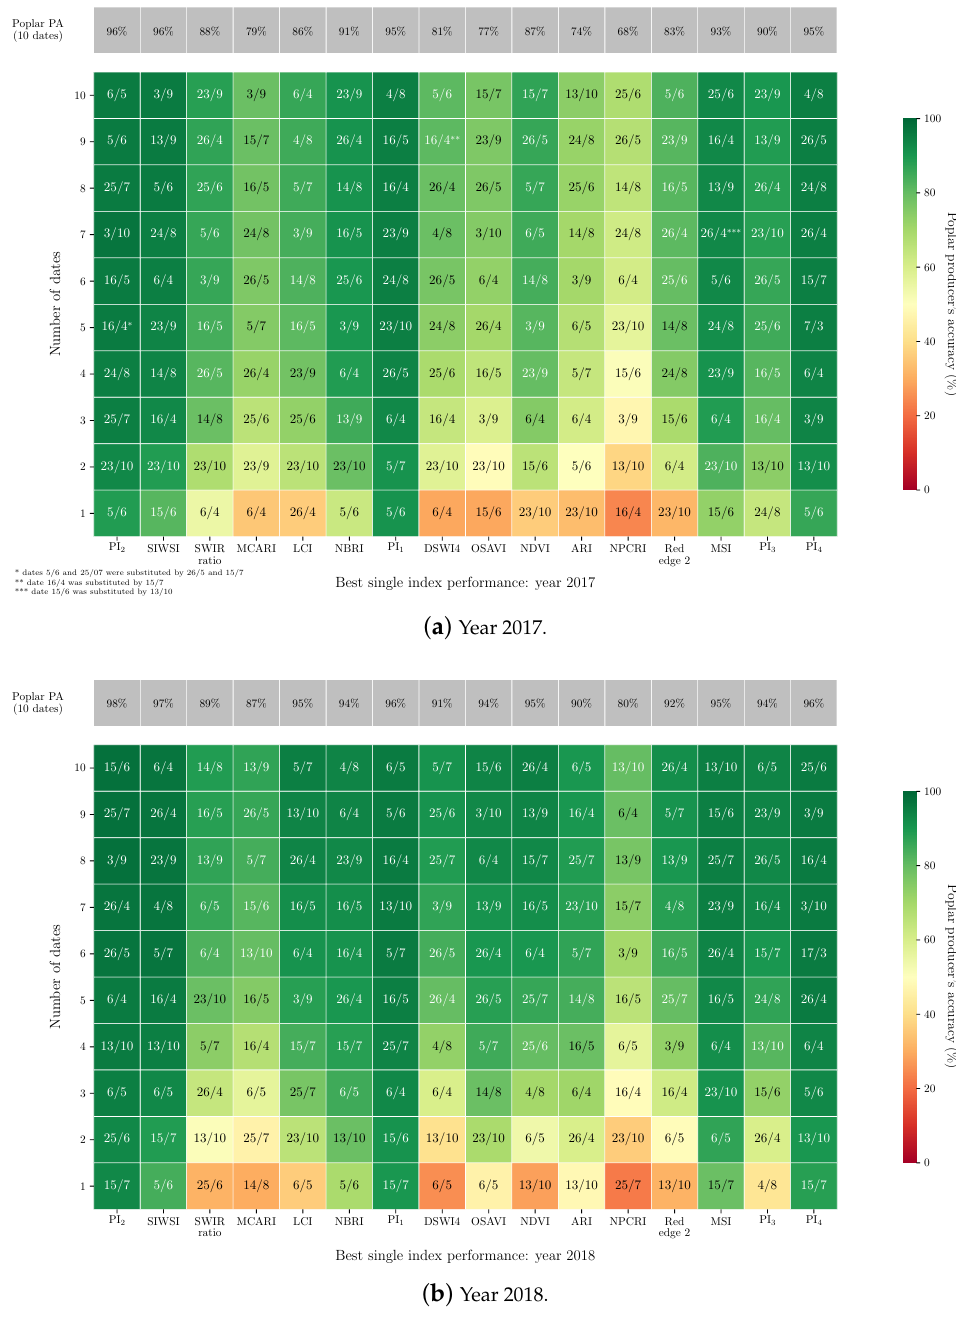
Figure 8. Average poplar PA as a function of the number of features selected with SFFS in the single-index configuration: in ( a ) single-index SFFS results in 2017; in ( b ), single-index SFFS results in 2018. The y-axis represents the number of features, from 1 to a maximum of 10, for each individual spectral index of the x-axis. The colours on the red-yellow-green scheme palette reflect the poplar’s PA values. The selected dates are given inside the